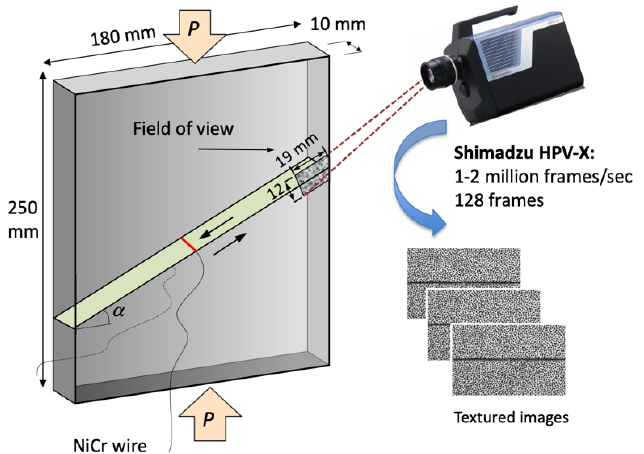
Fig. 2. Schematic of the experimental configuration used in this study featuring a dynamic rupture along a frictional interface approaching the free surface and an ultrahigh-speed camera capturing the transient event at 1 million